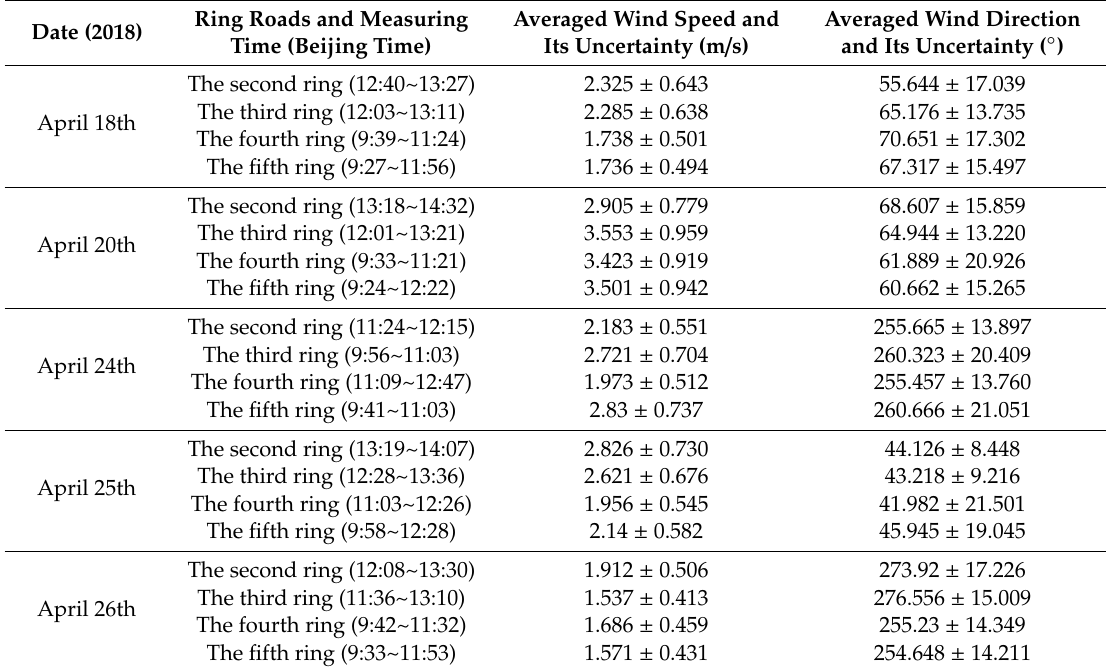
Table 2. The ring roads’ measuring data, measuring time, averaged wind field, and its uncertainty